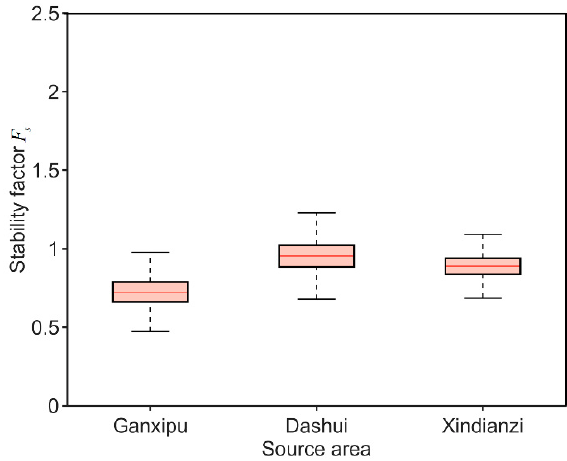
Figure 8. The stability factors of the critical slip surface.